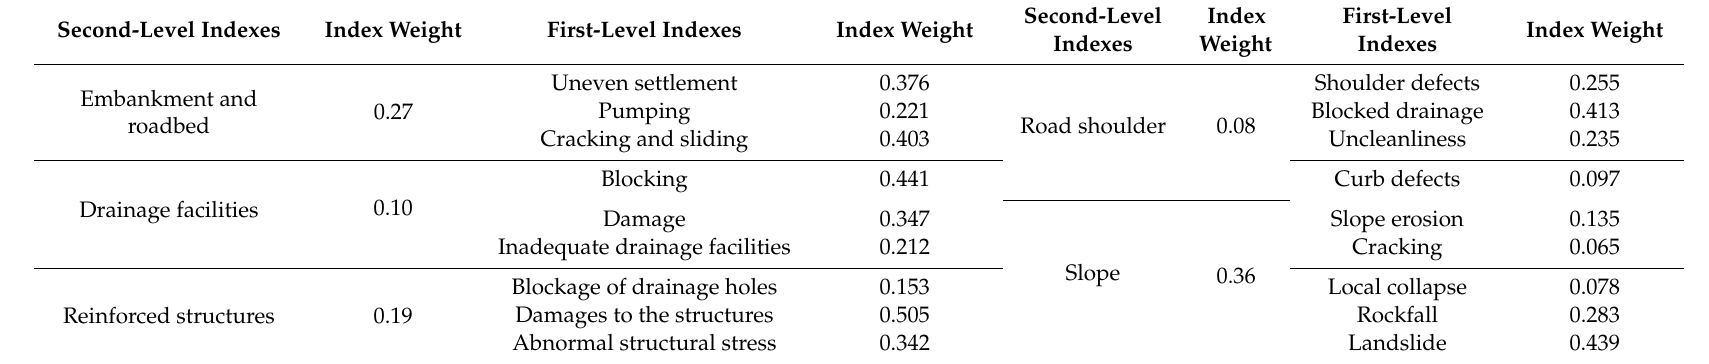
Table 2. The assessment system of the subgrade